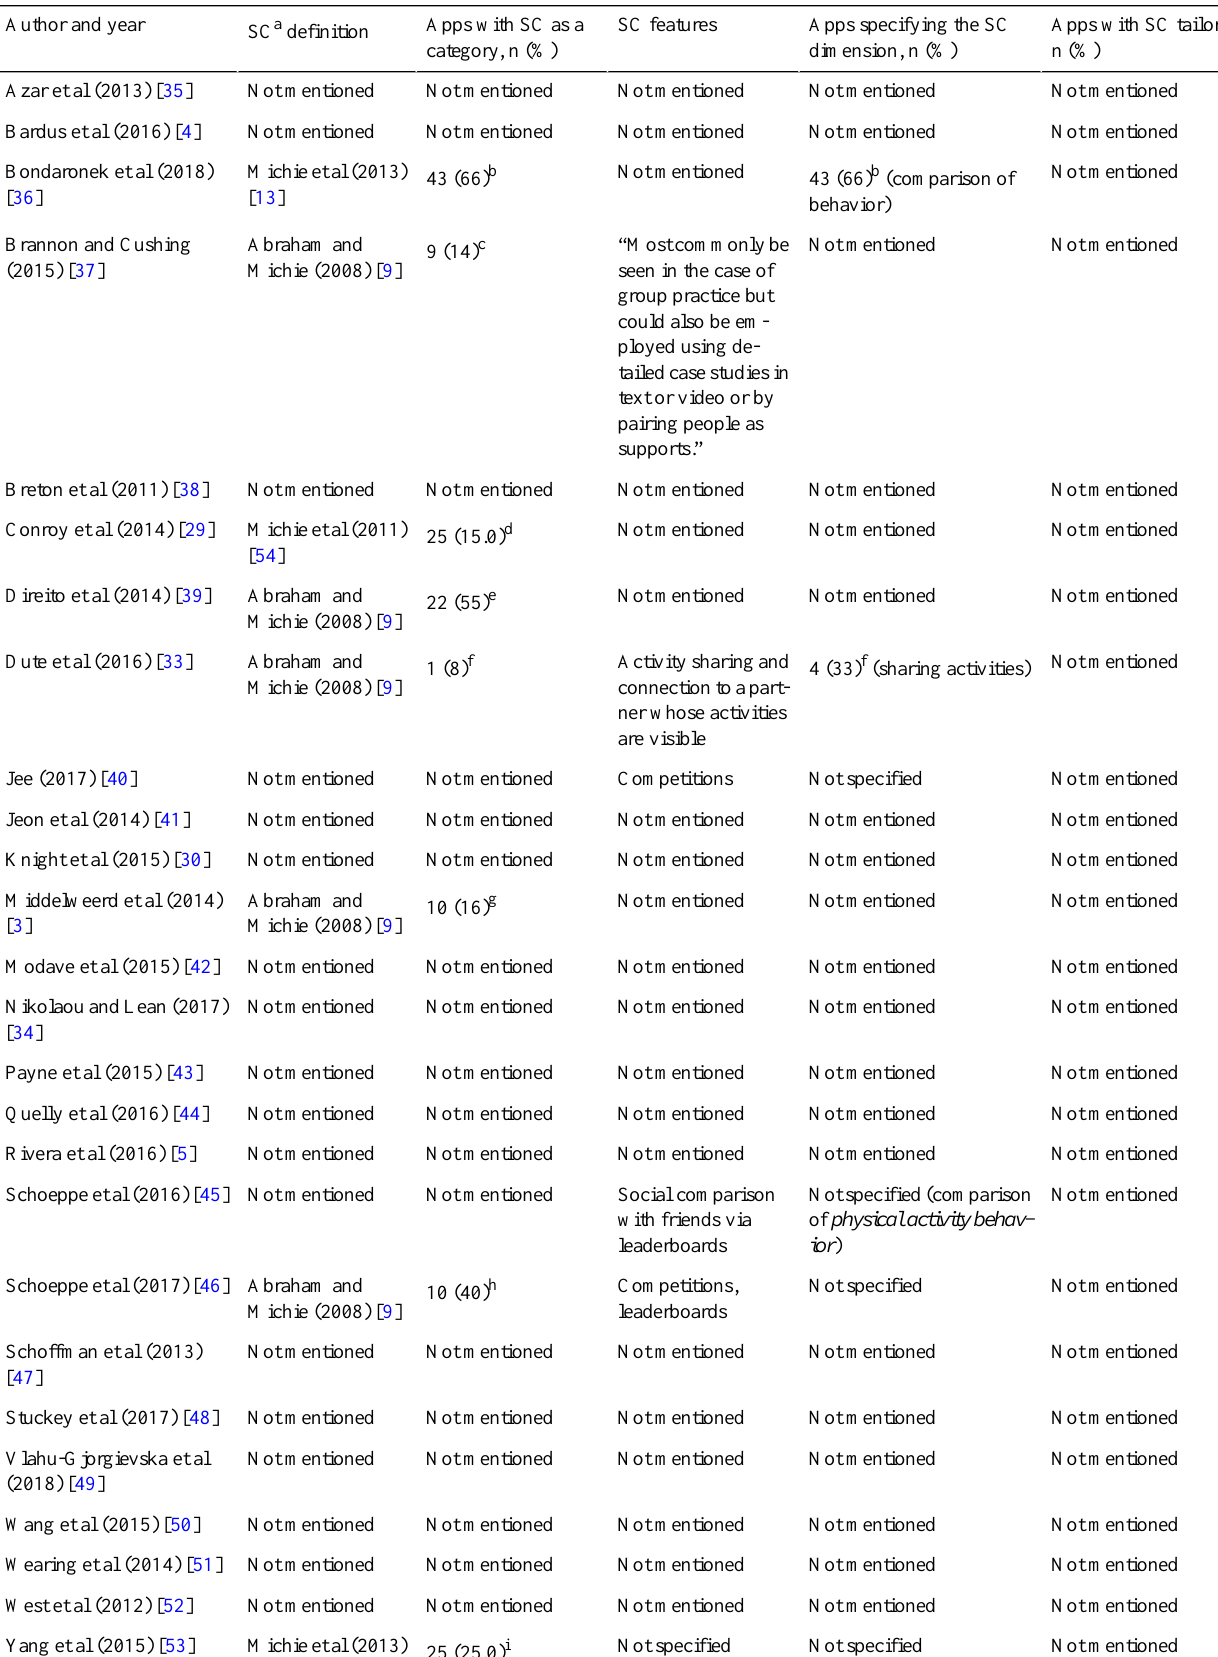
Table 2. Summary of social comparison data extracted from each review of physical activity apps.